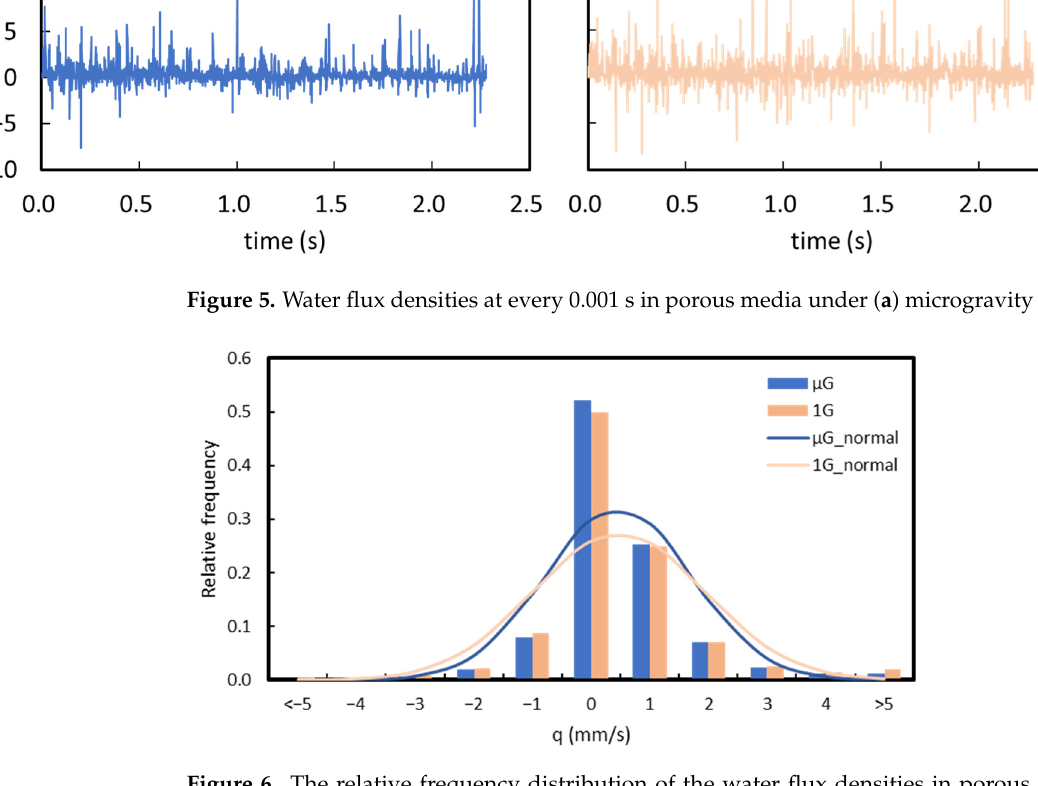
Figure 6. The relative frequency distribution of the water flux densities in porous media under microgravity and 1 G. The bar and lined graph indicated the measured and normal frequency distribution, respectively.